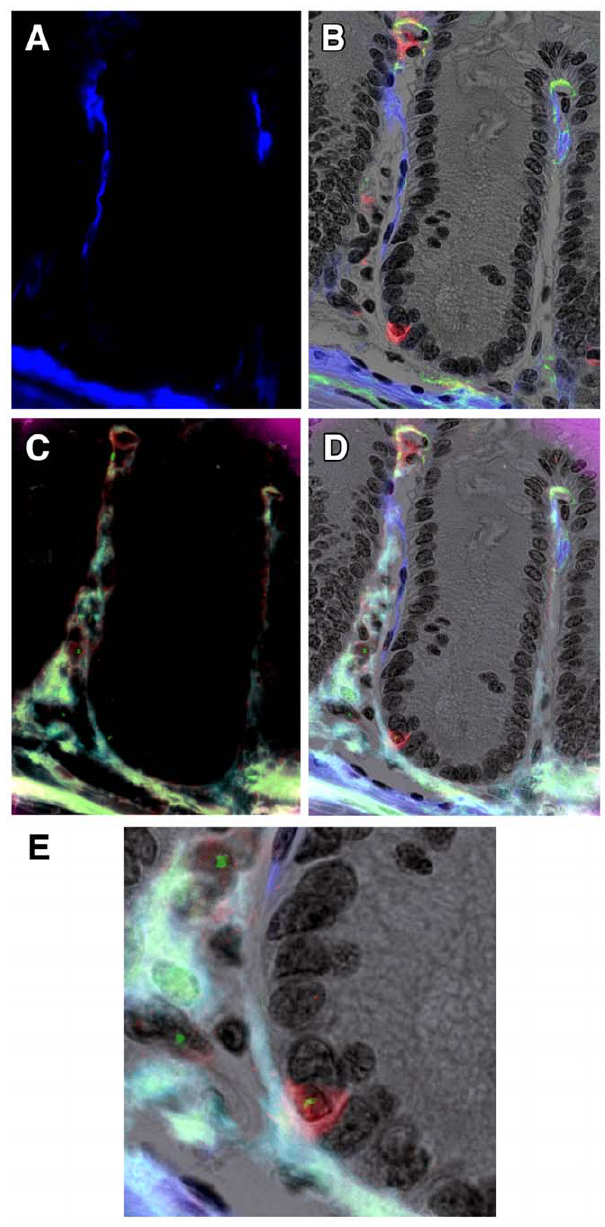
Figure 2. Double IHC for a -SMA and CD45 with Y chromosome paint. A colonic crypt from a female Rag2 2 / 2 mouse transplanted 28 days earlier with male SWR BM. A. a -SMA was stained using two layer IHC with a Cy5-conjugated second layer, here false-coloured blue. B. CD45 was revealed using 3 layer IHC using Vector Red as chromogen for alkaline phosphatase-conjugated streptavidin, here revealed in fluores- cent mode using the Cy3 filter, in combination with the brightfield greyscale image (with nuclei stained with haematoxylin), and overlaid with the a -SMA image from A. Note the close morphology of the CD45- positive cell to that of its neighbours. C. Subsequent Y chromosome paint (green nuclear spots, FITC filter) on the same section. Note background fluorescence revealing some tissue morphology. D. Overlay image of B and C showing the CD45 cell to be Y chromosome-positive, together with some stromal male cells. E. Magnified view of part of D. Original magnifications: A-D 200X, E 400X.